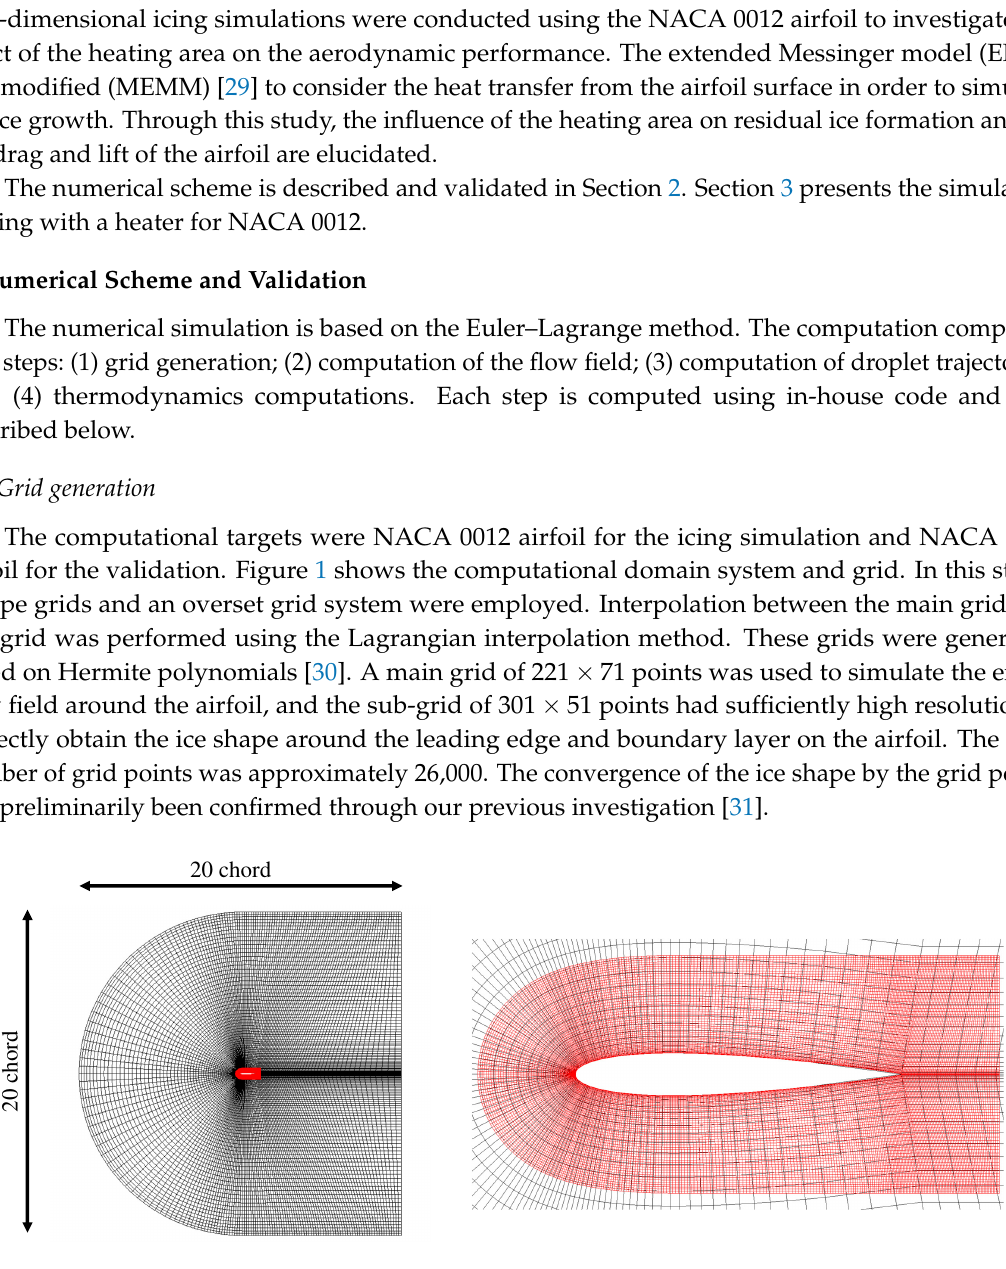
Figure 1. Computational grid for NACA 0012. The left and right figures show the overall and enlarged view around the airfoil, respectively. The red and yellow grids show the sub- and main computational grids,